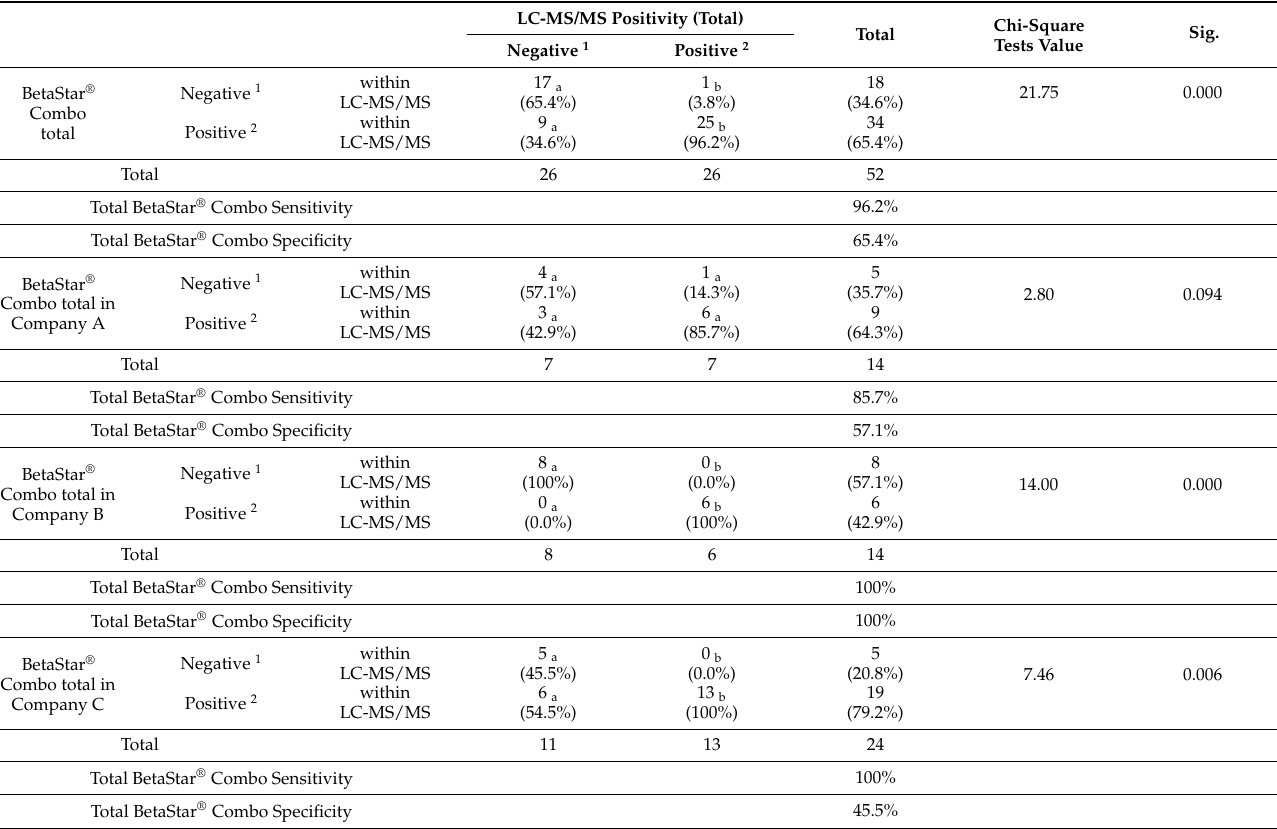
Table 4. Sensitivity and specificity of BetaStar ® Combo test regarding LC-MS/MS results in all